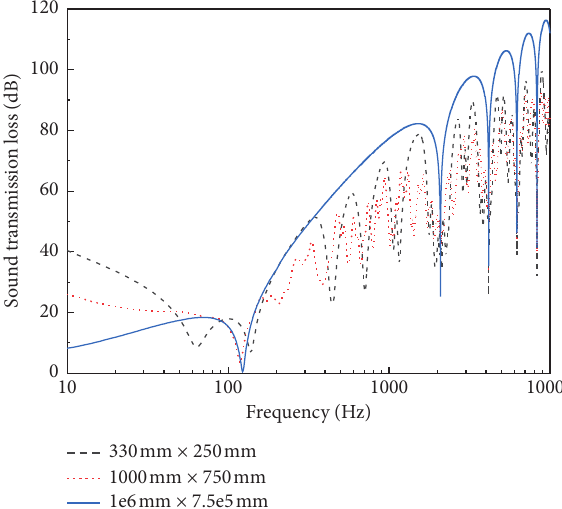
Figure 5: Influence of the size of the double-panel partition on the sound transmission loss in vertical incidence.